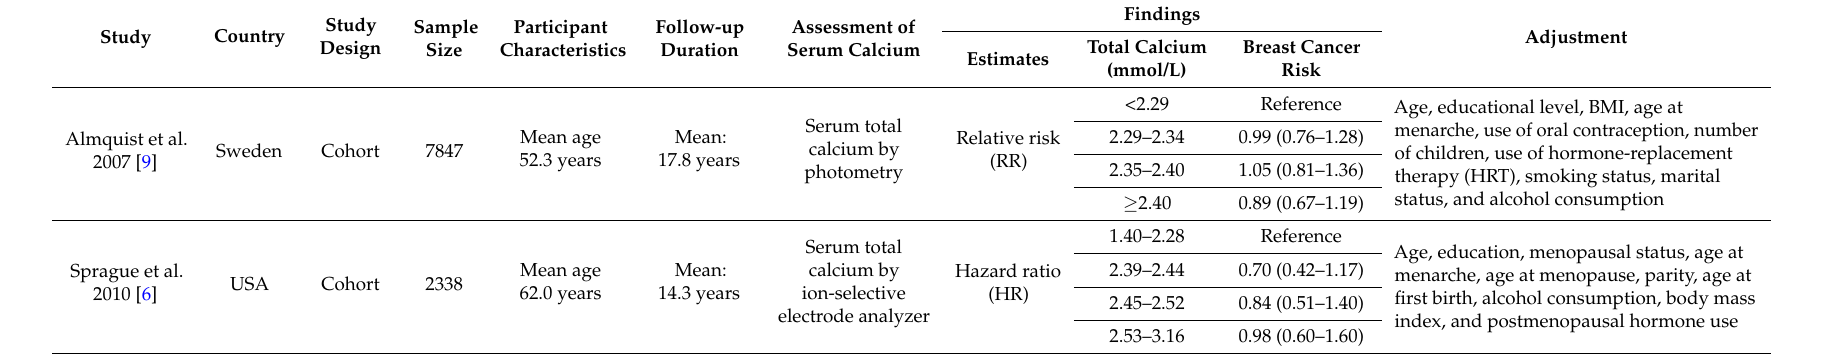
Table 3. Description of studies included in the meta-analysis apart from the AMORIS